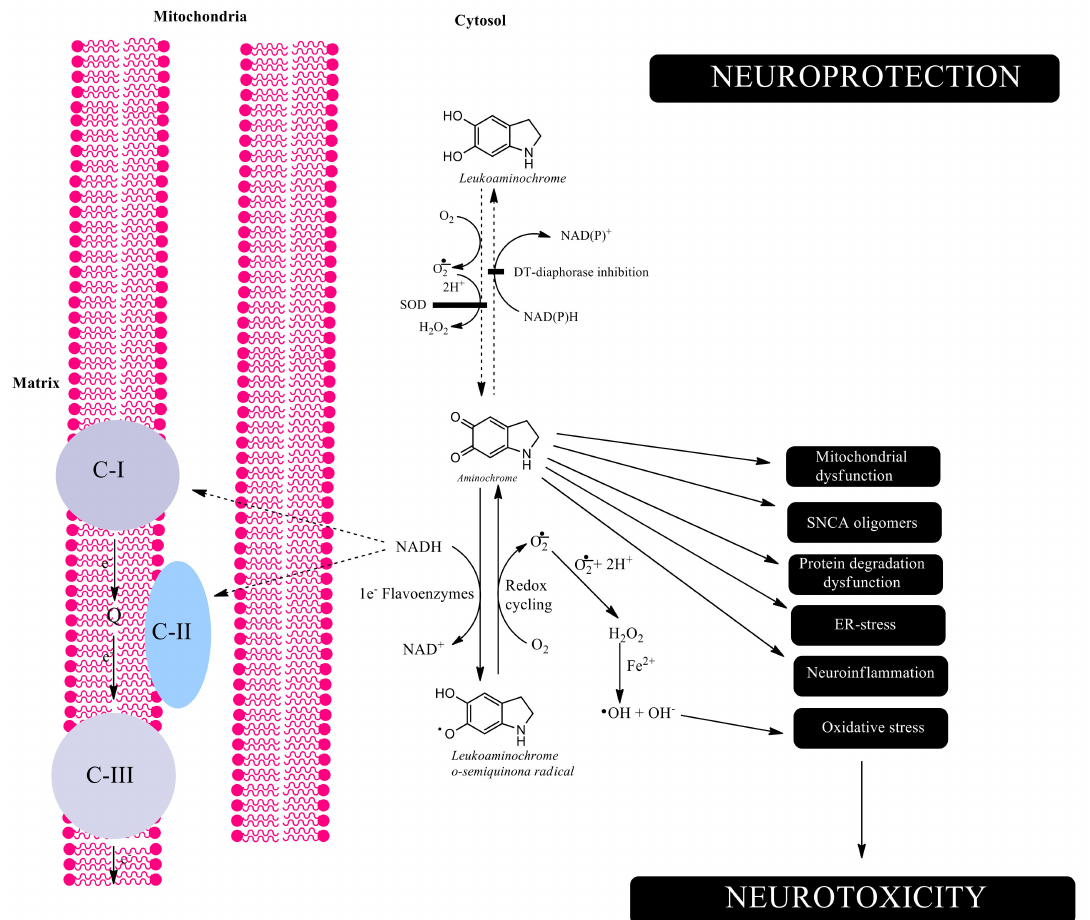
Figure 3. Aminochrome-induced neurotoxicity. DT-diaphorase catalyzes the reduction of aminochrome with two electrons to leukoaminochrome, preventing the neurotoxic effects of aminochrome. Leukoaminochrome can autoxidize very slowly in the presence of dioxygen, gen- erating superoxide. However, the autoxidation of leukoaminochrome is significantly faster in